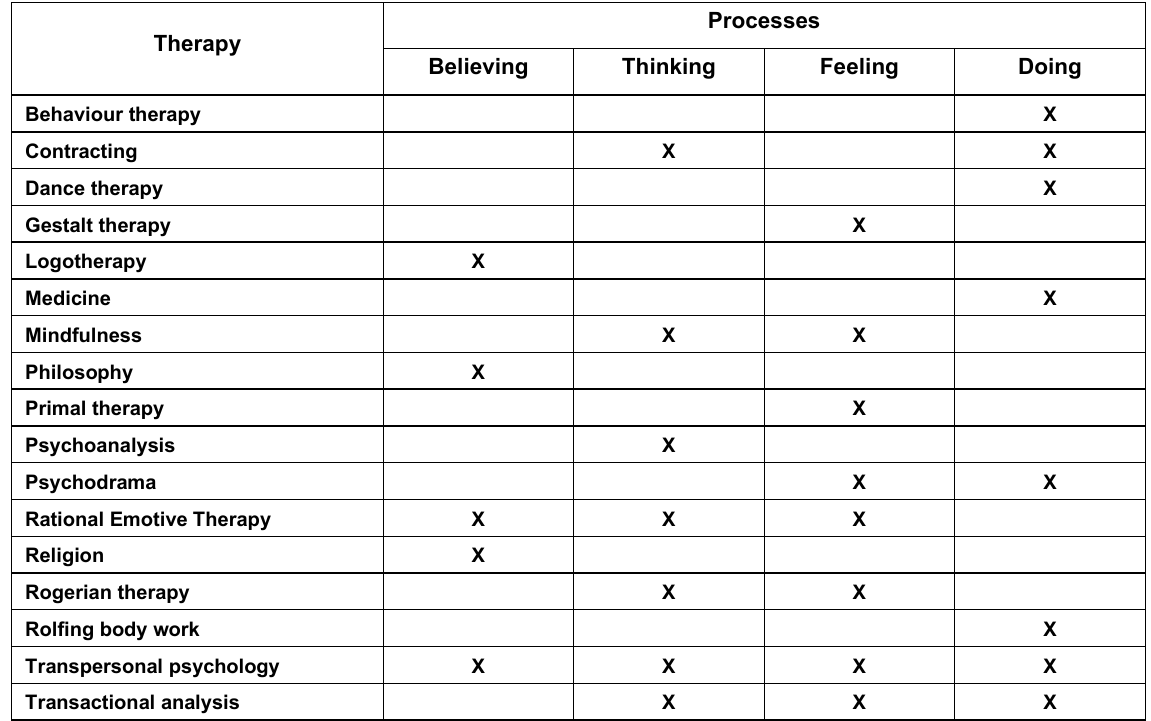
Table 1: Psychotherapy Approaches to 4 of the Corners (modified from Mellor, 1080, p.350)